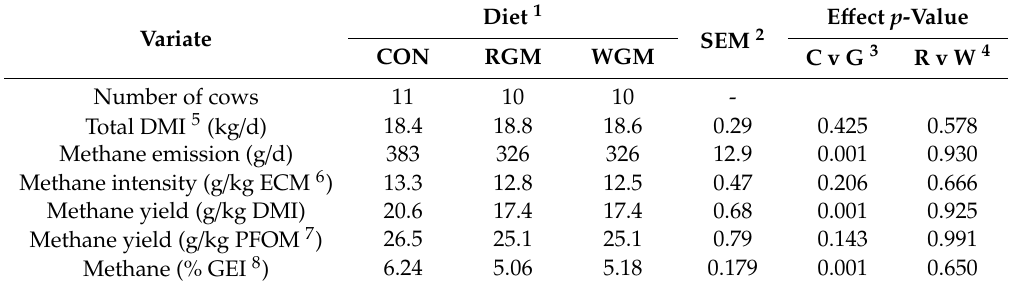
Table 7. E ff ect of feeding diets containing grape marc on methane emissions from dairy cows. Variate